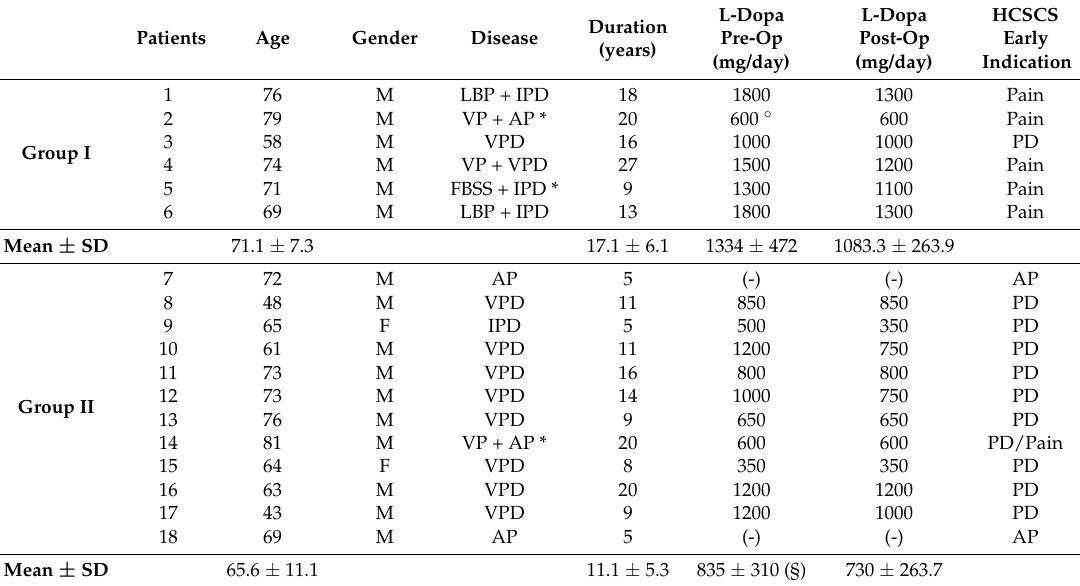
Table 1. Demographic and clinical characteristics of